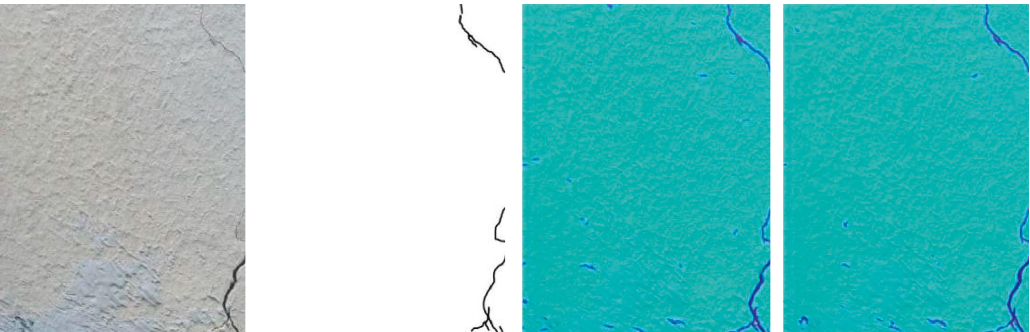
Figure 6: Crack detection results of FCN-8s and the new network.